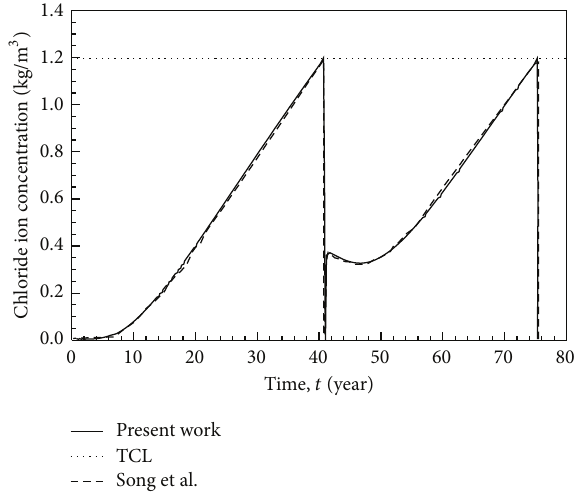
Figure 4: History of chloride ion concentration at the interface between the concrete cover and the column. Comparison with computations of Song et al. [7] for a one-dimensional case with CT = 80